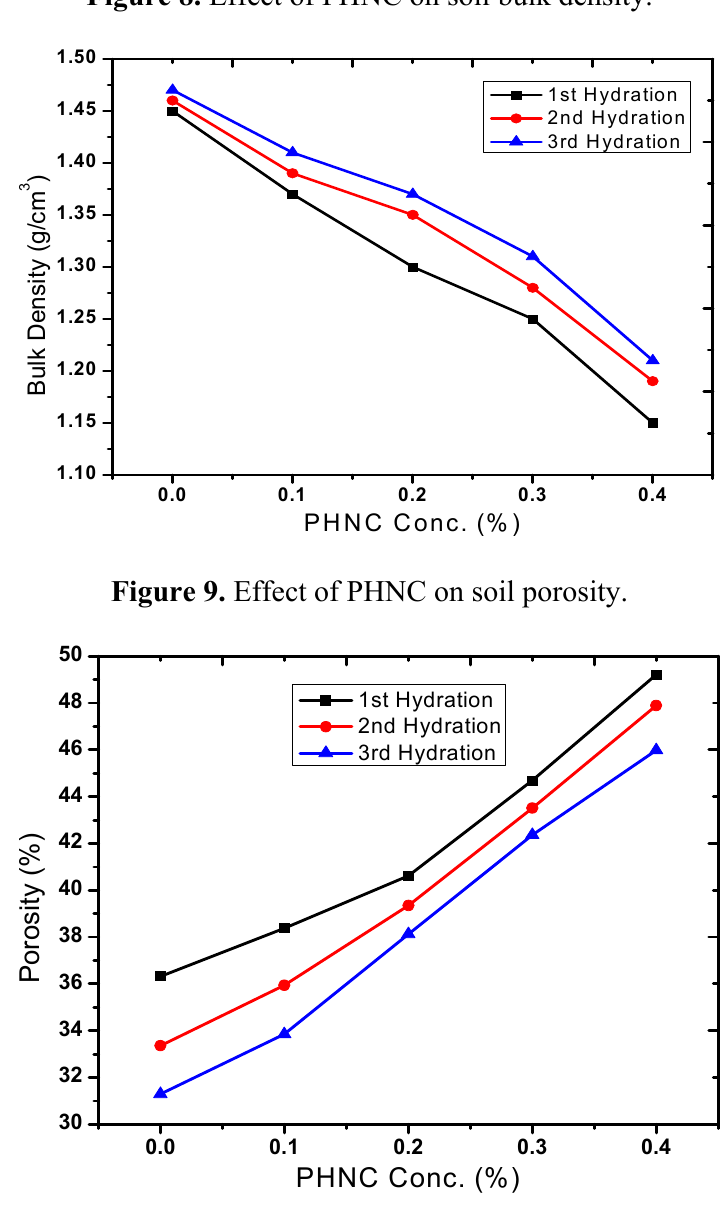
Figure 8. Effect of PHNC on soil bulk density.